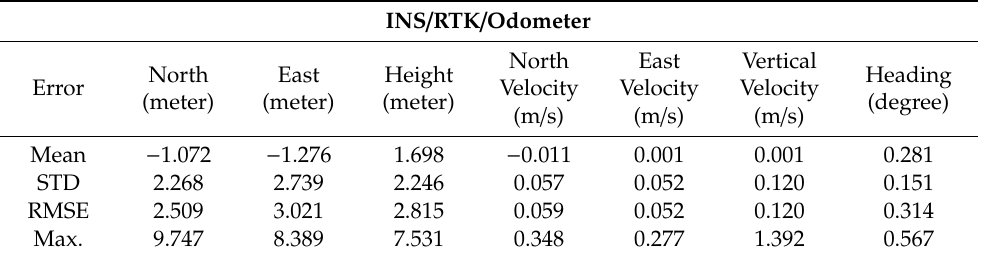
Table 2. Statistical analysis of the INS / real-time kinematic (RTK) / odometer.